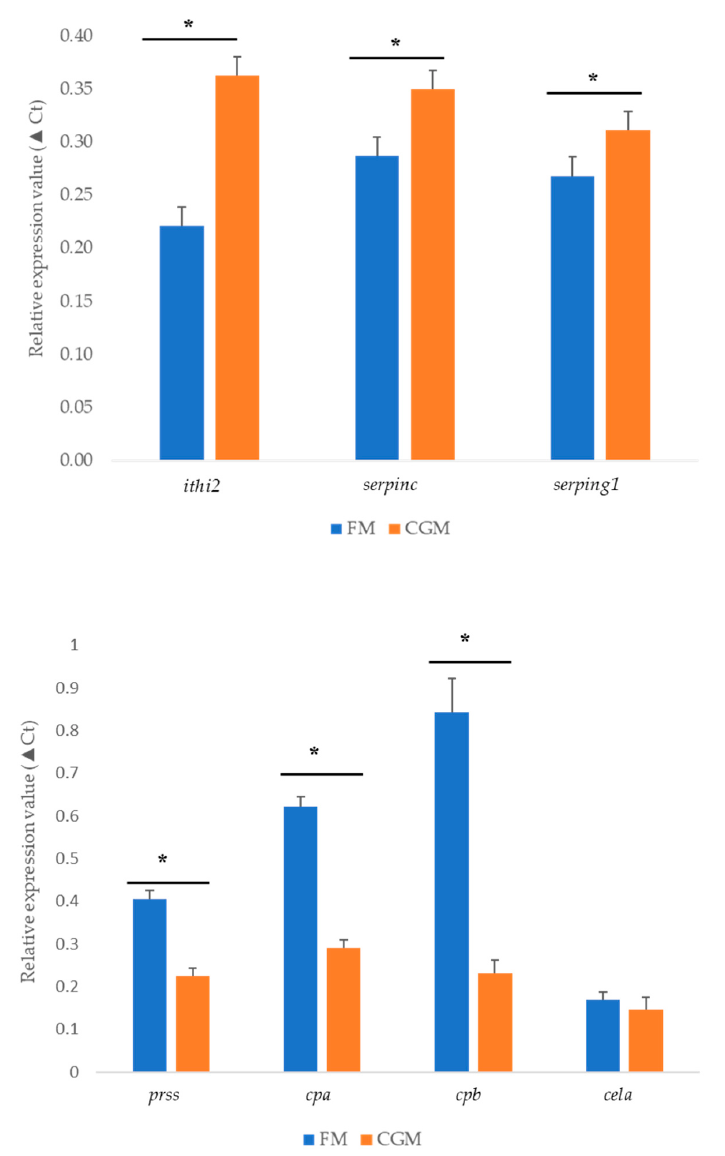
Figure 5. Quantitative polymerase chain reaction (qPCR) validation for 7 genes related to protein